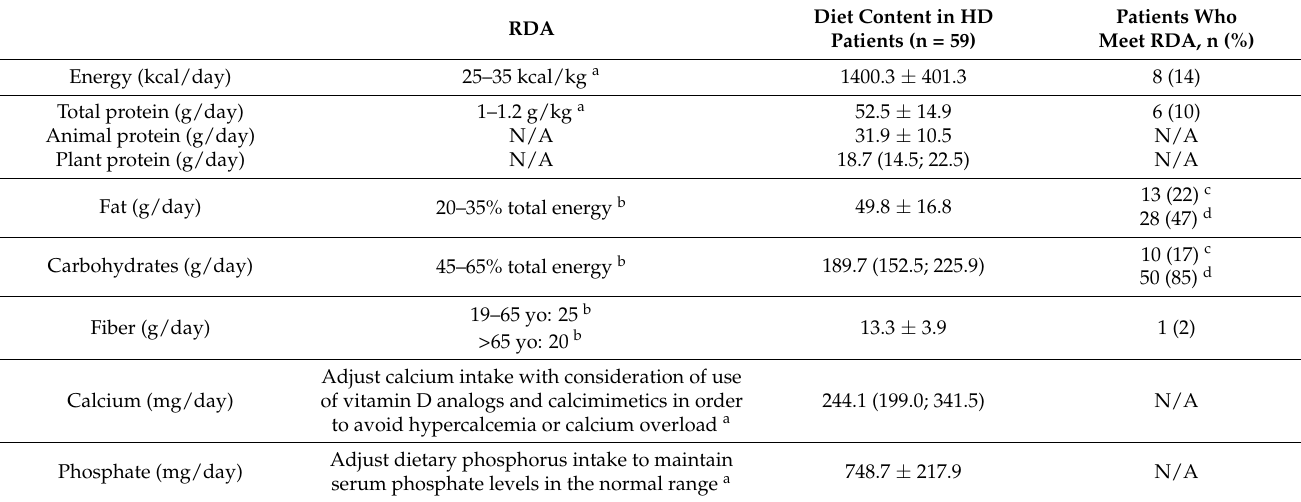
Table 3. Recommended daily allowance and the evaluation of the studied HD patients’ diet. The values are given as mean ± SD standard deviation or median (Q1; Q3). The diet content was assessed twice, in post-summer and post-winter periods, and the arithmetic mean was calculated from the